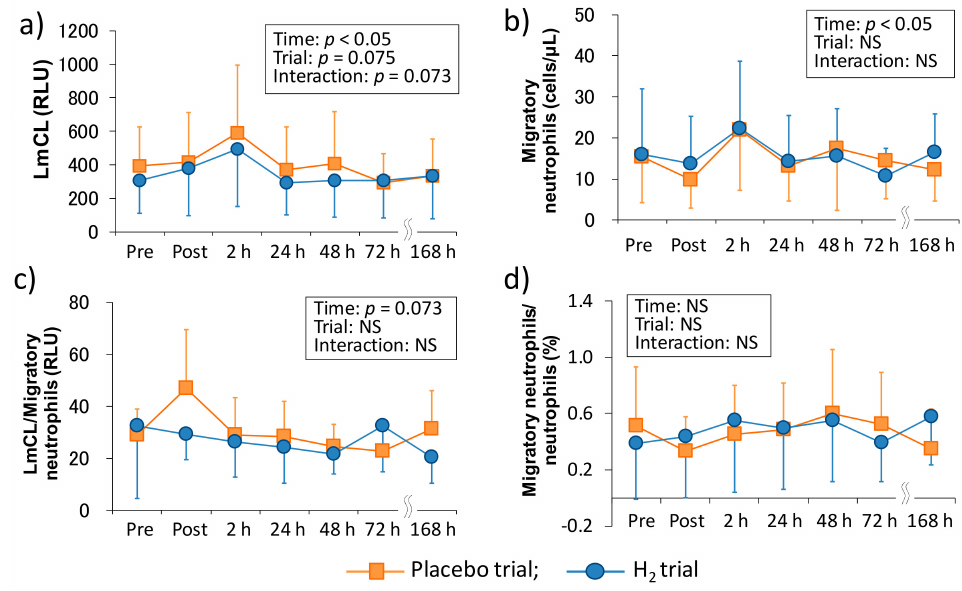
Figure 2. Time-course changes of neutrophil functions after downhill running. ( a ) Reactive oxygen species productivity of neutrophils, ( b ) migratory neutrophils count, ( c ) reactive oxygen species productivity of neutrophils/migratory neutrophils ratio, and ( d ) migratory neutrophils count/peripheral neutrophil count ratio. LmCL, luminal-dependent chemiluminescence; RLU, relative light unit; Pre, Pre exercise; Post, approximately 40 min after exercise (end of bath), 2, 24, 48, 72, and 168 h after exercise. Data are presented as the means ± standard deviations (SD) of nine subjects in each trial (placebo: n = 9, H 2 trial: n = 9). There was a significant time effect in the reactive oxygen species productivity of neutrophils ( p < 0.05), and the migratory neutrophils count ( p < 0.05) (two-way ANOVA for repeated